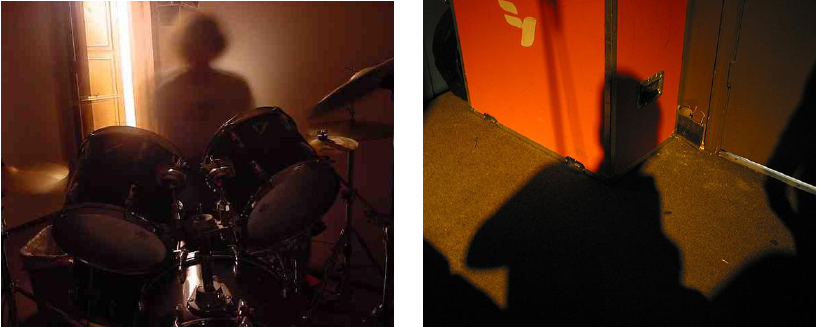
Figure 12. Low aesthetic quality samples from the CUHKPQ database in which the face is not